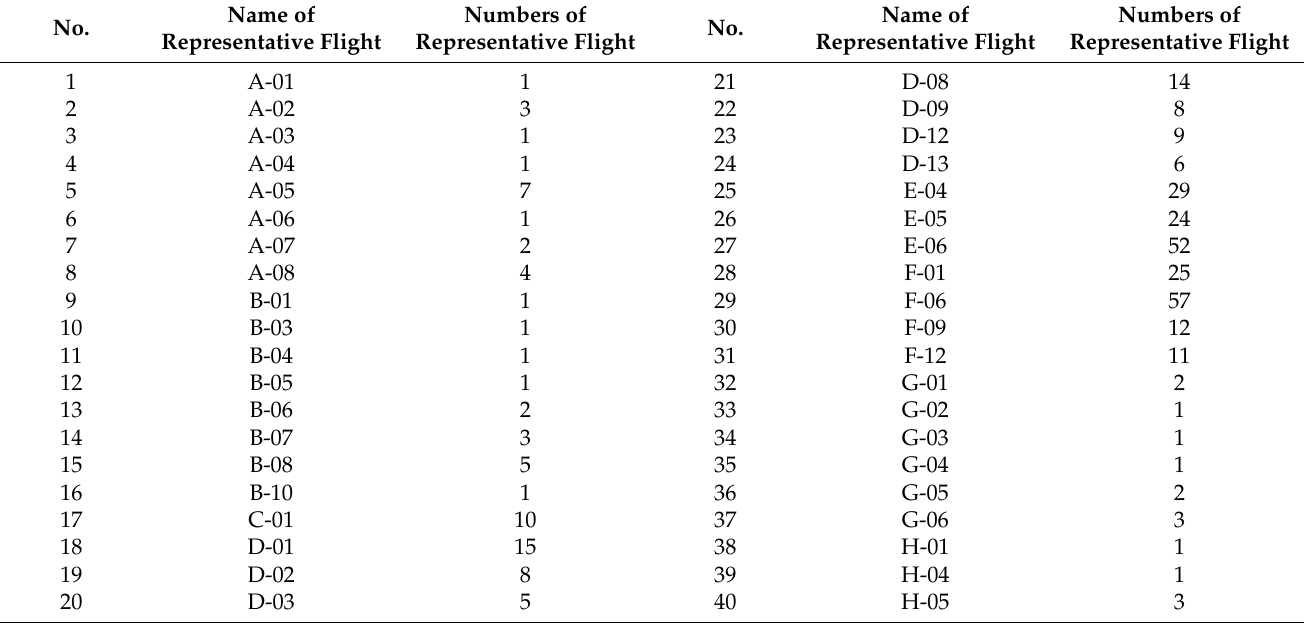
Table 1. 40 representative flights and their occurrences in the reference